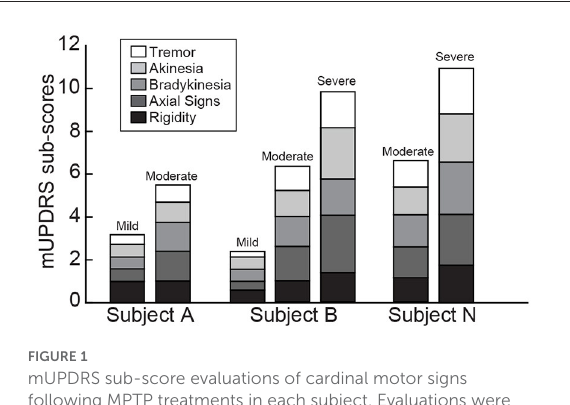
FIGURE1 mUPDRS sub-score evaluations of cardinal motor signs following MPTP treatments in each subject. Evaluations were conducted in the mild parkinsonian state for two subjects (B, A), moderate parkinsonian state for all subjects, and severe parkinsonian state for two subjects (B, N). mUPDRS sub-scores included evaluation of the most affected side of the body for tremor, akinesia, bradykinesia and rigidity, plus whole-body axial motor signs. The span of each bar represents the sub scores and the height reflects the total additive